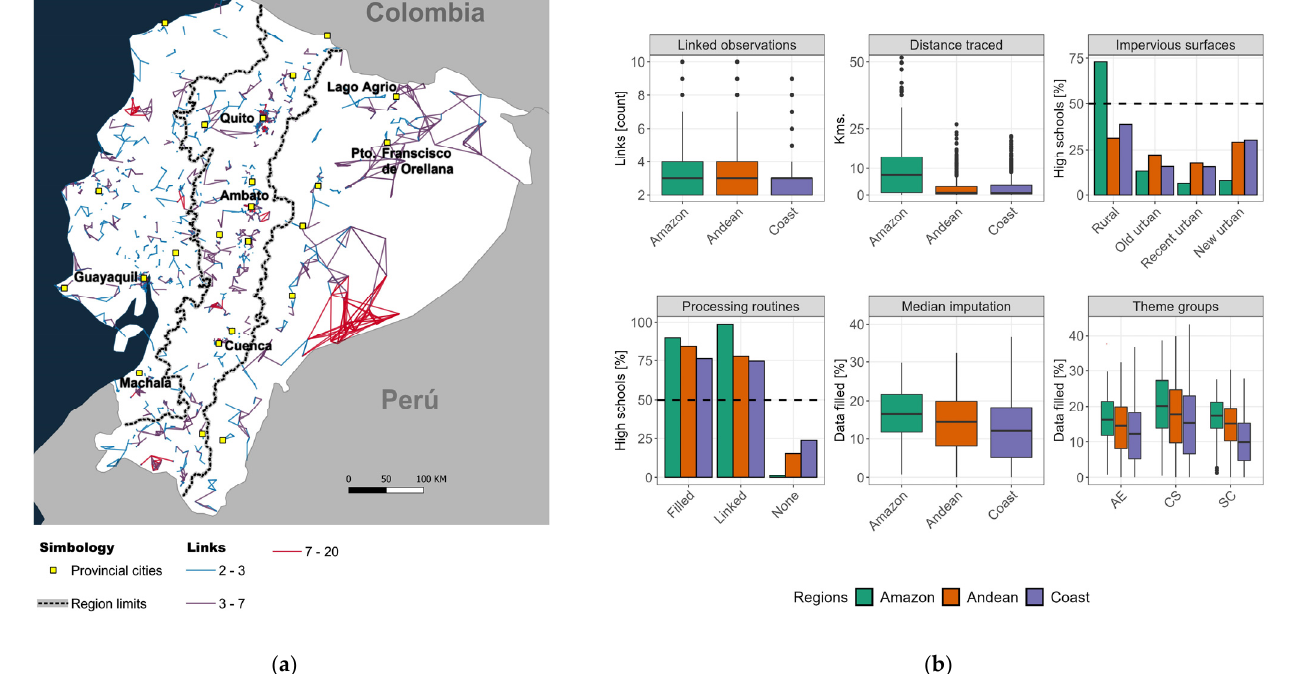
Figure 3. ( a ) High school linkages based on distance; ( b ) sample feature characterizations by region.